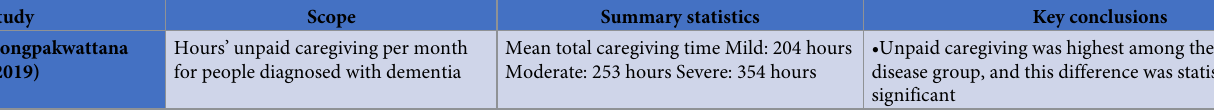
Table 5. Results of studies quantifying unpaid